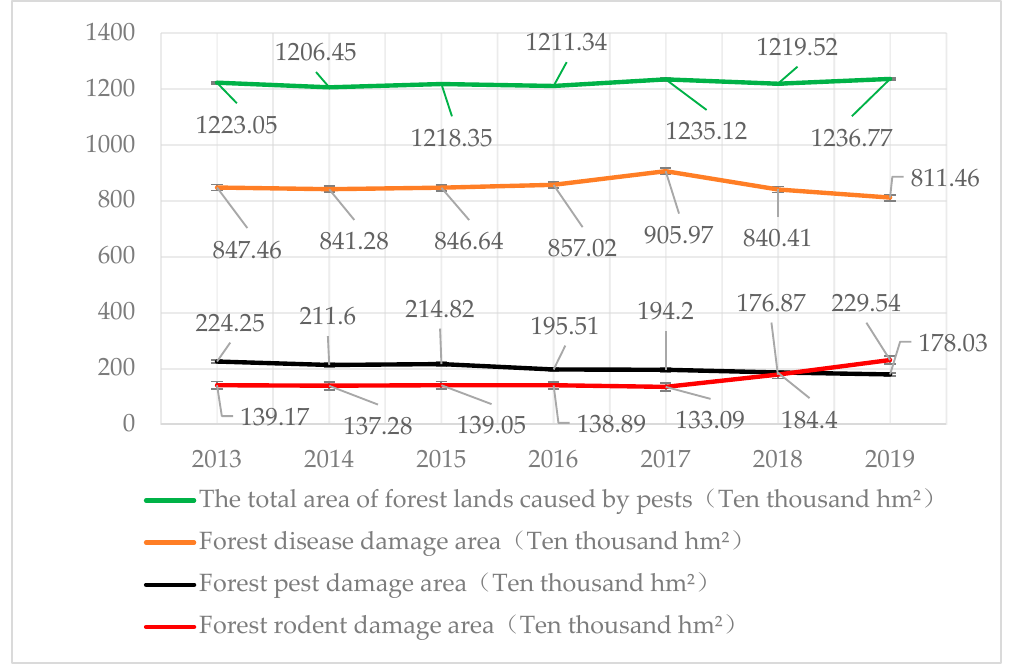
Figure 3. Yearly changes in the area affected by pests in China (2013–2019).